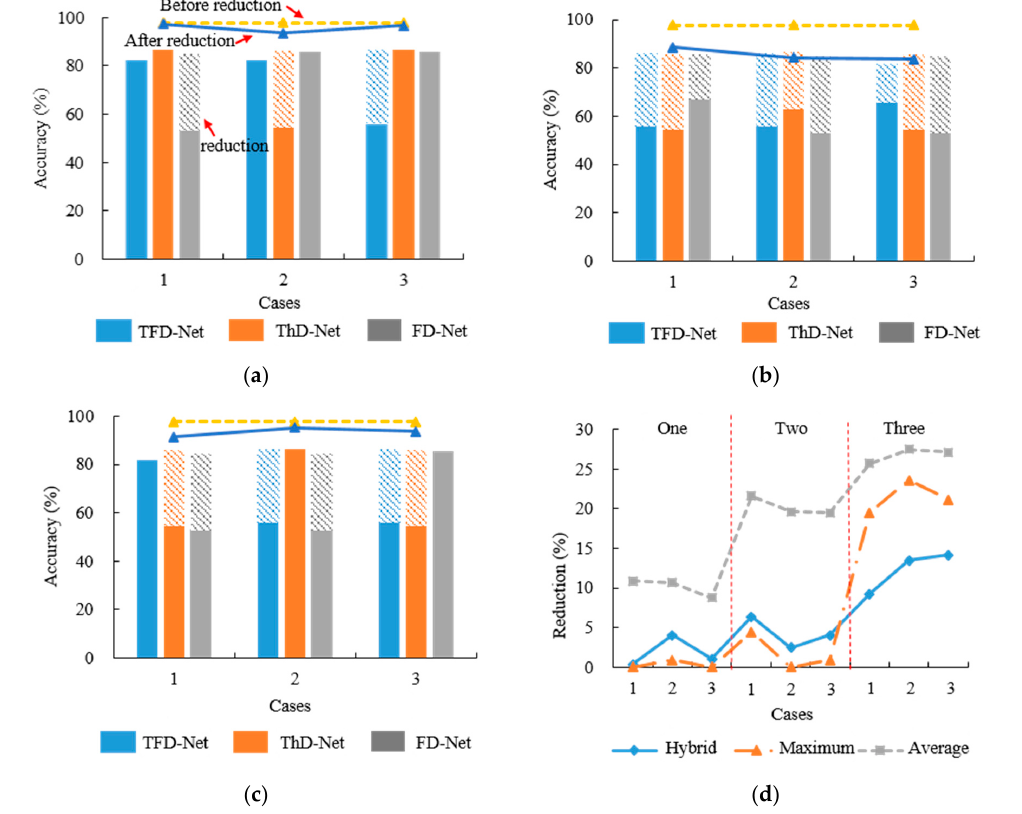
Figure 12. The accuracy changes of the hybrid Ada-DCNN, Ada-DCNNs, and DCNNs under different schemes: ( a ) Changes in accuracy with one DCNN dropped; ( b ) Changes in accuracy with two DCNNs dropped; ( c ) Changes in accuracy with three DCNNs dropped; ( d ) Reductions from the reference accuracy under each scheme. Table 8. Performance of the hybrid Ada-DCNN, Ada-DCNNs, and DCNNs under different schemes (“/” represents no change).